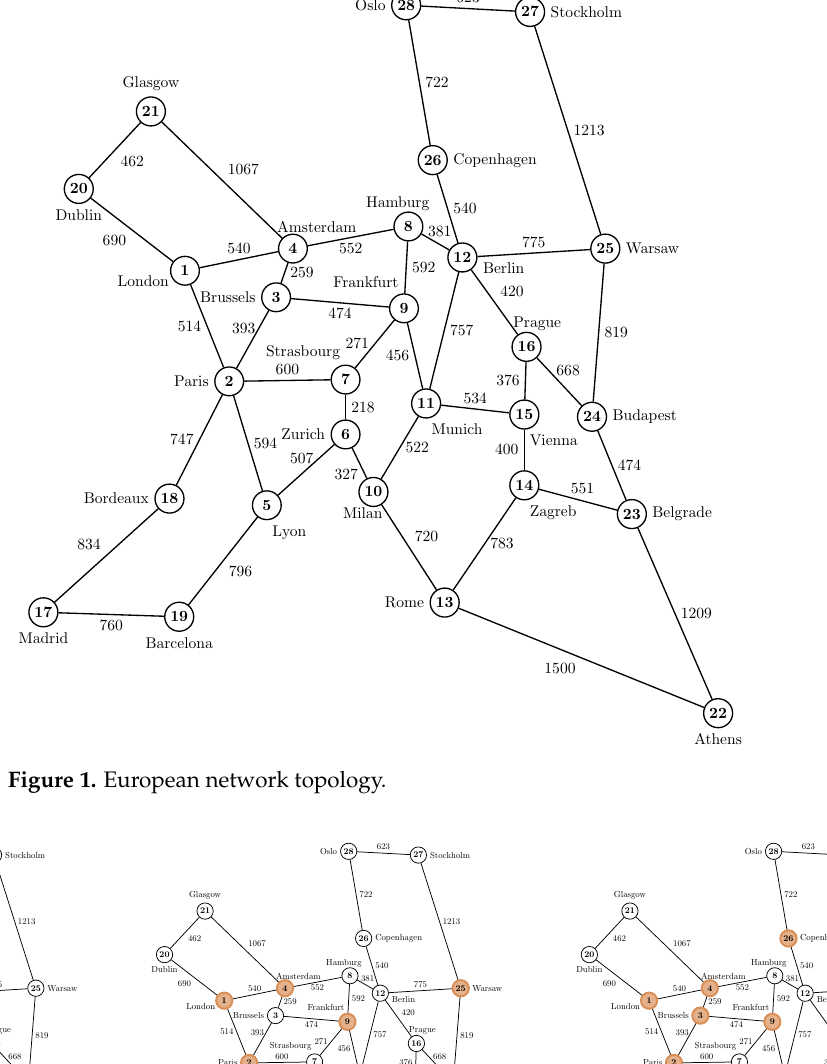
( c ) 11 data centers